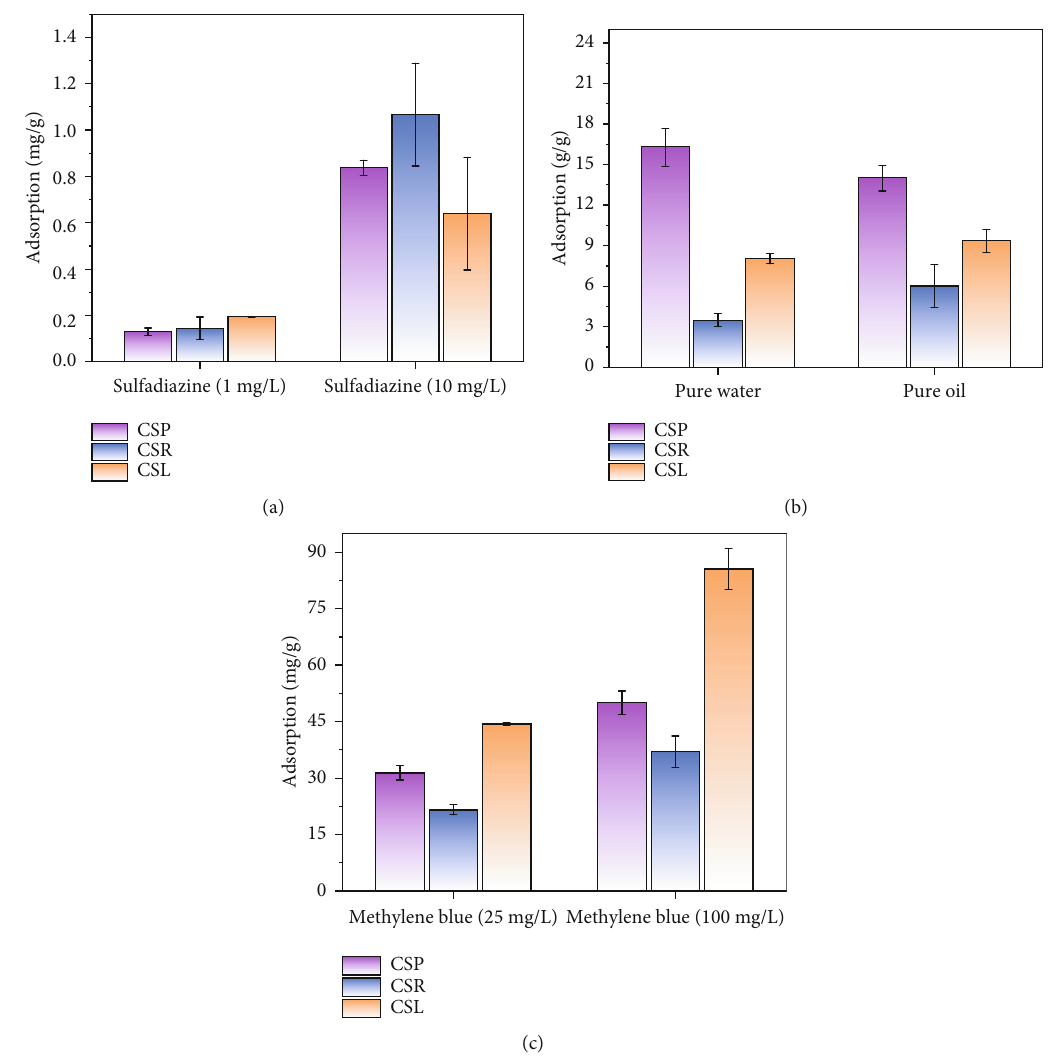
Figure 7: The adsorption capacities of di ff erent parts of the corn